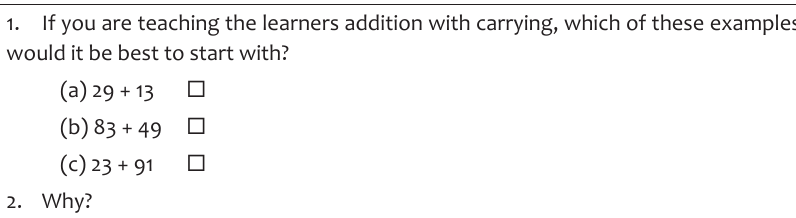
Figure 6: Example of question on exemplifying for